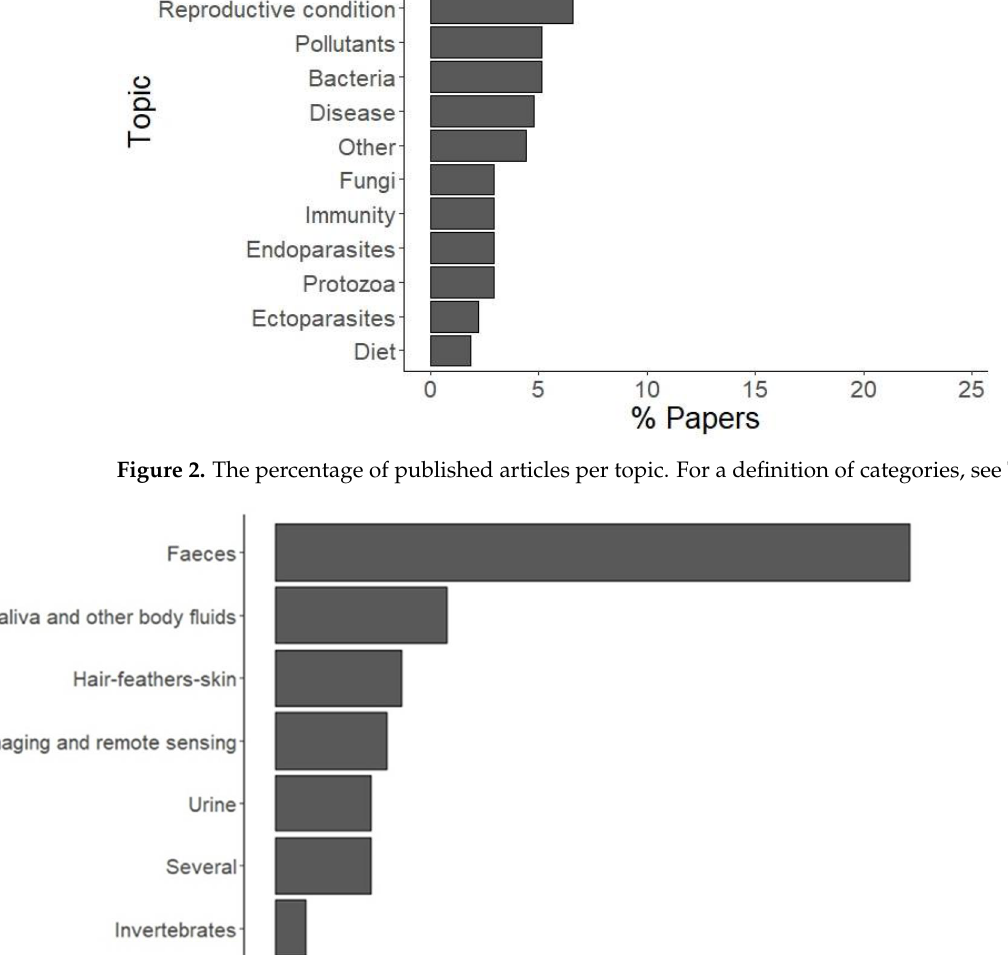
Figure 2. The percentage of published articles per topic. For a definition of categories, see Table 1.